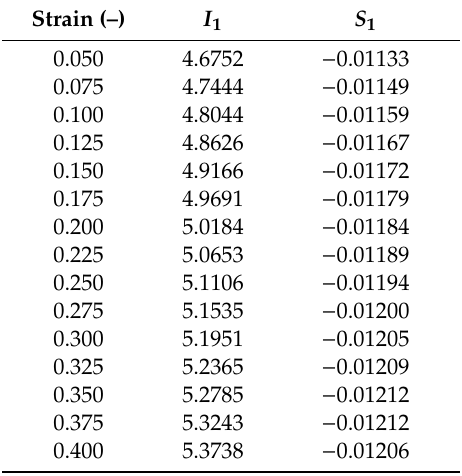
Table 1. The value of S 1 and I 1 for 15 strains.